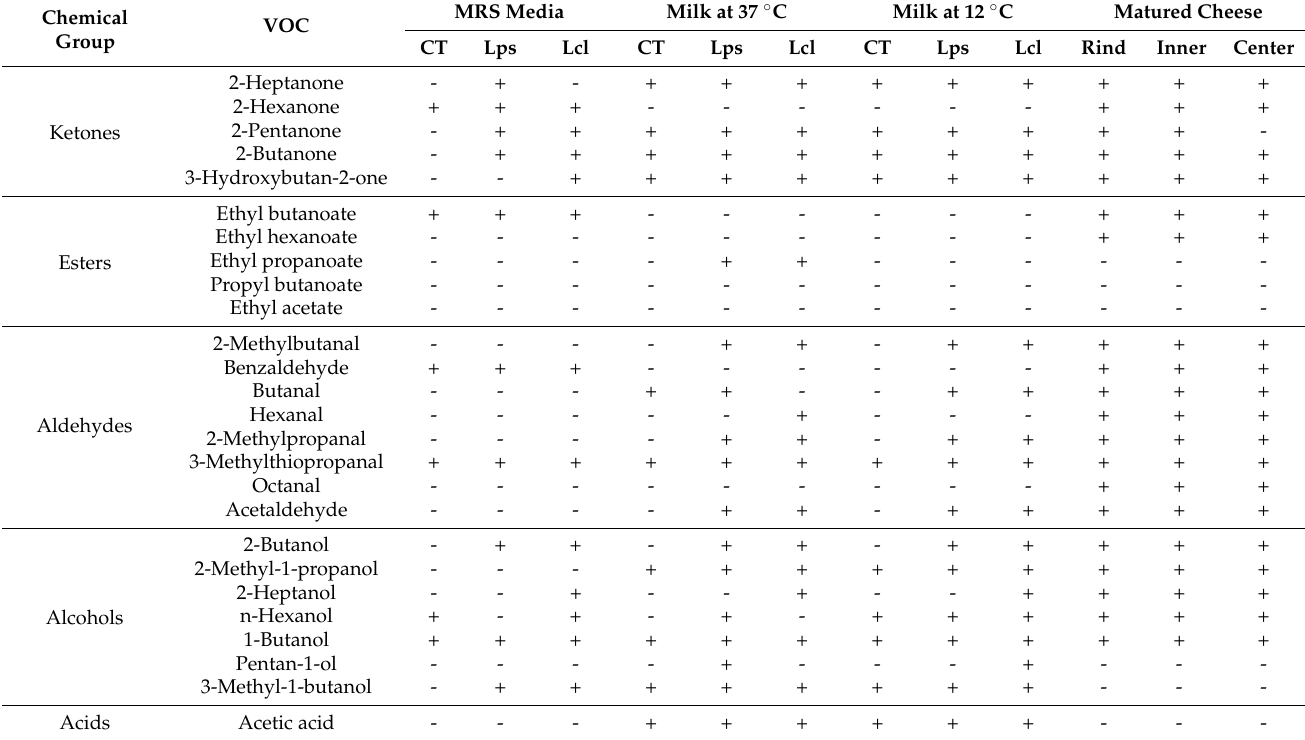
Table 3. VOCs detected in LAB cultures and raw sheep milk matured